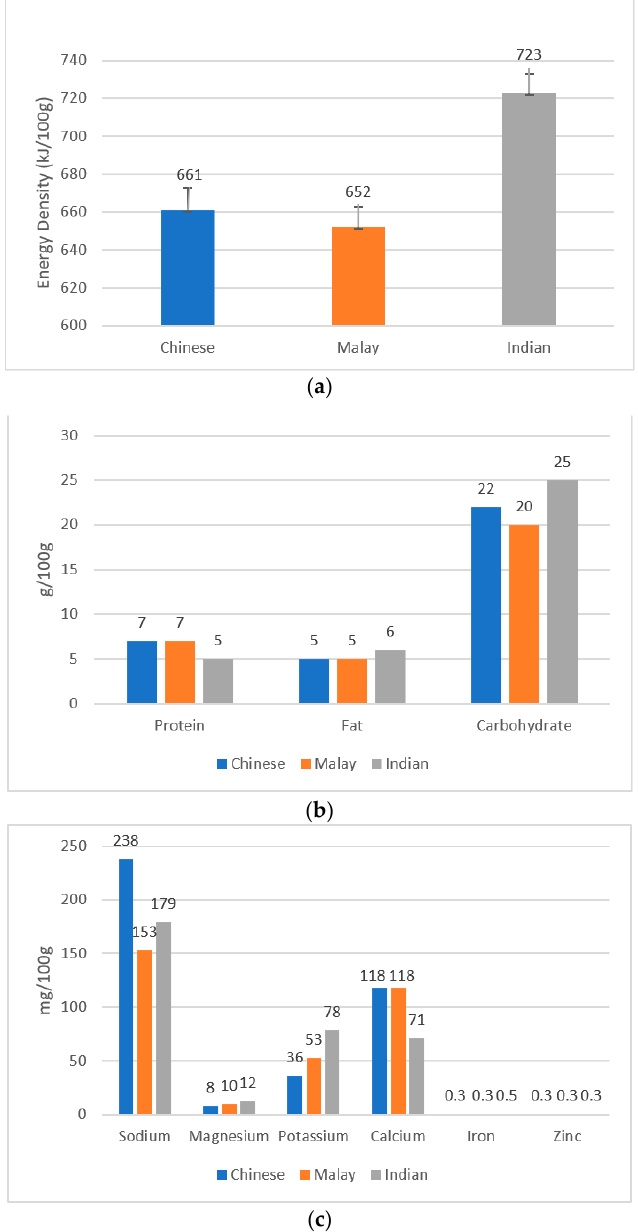
Figure 1. Comparisons of ( a ) energy density, ( b ) macronutrient content, and ( c ) mineral content between the different ethnic cuisines.